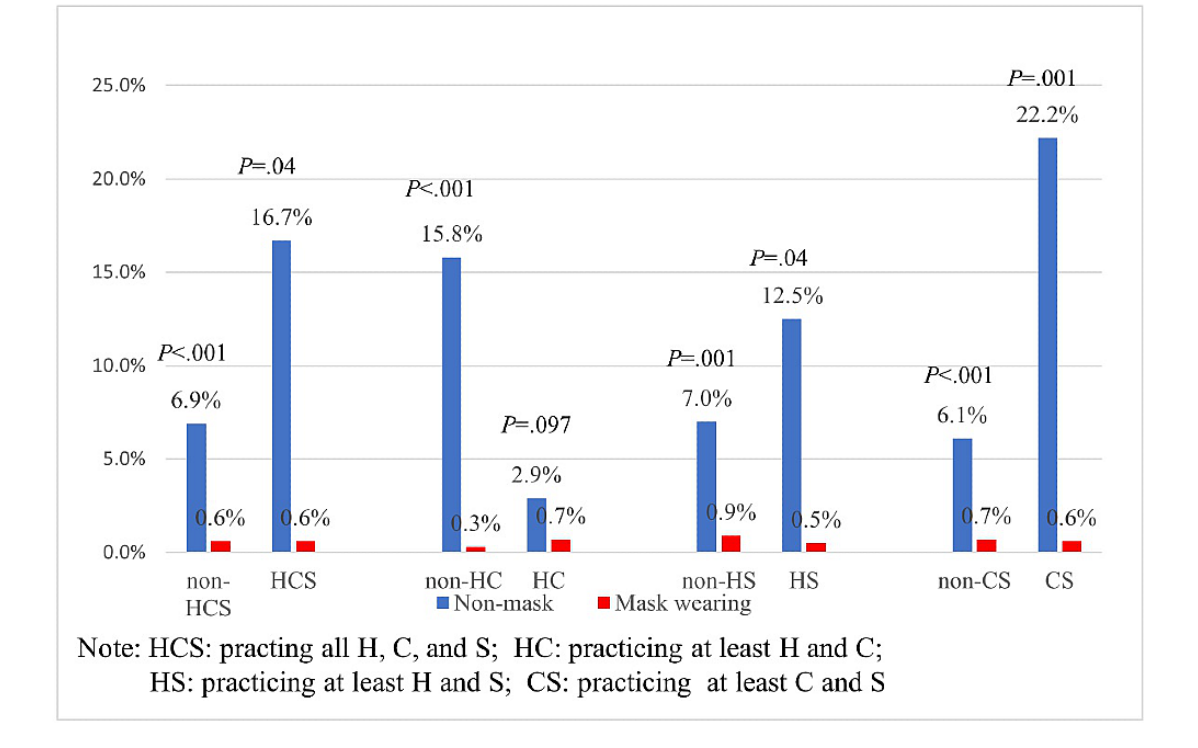
Figure 2. The COVID-19 infection rates between mask wearing and the combinations of the other three nonpharmaceutical interventions: H, C, and S. P values from Fisher exact test. C: proper coughing habit; H: handwashing; S: social